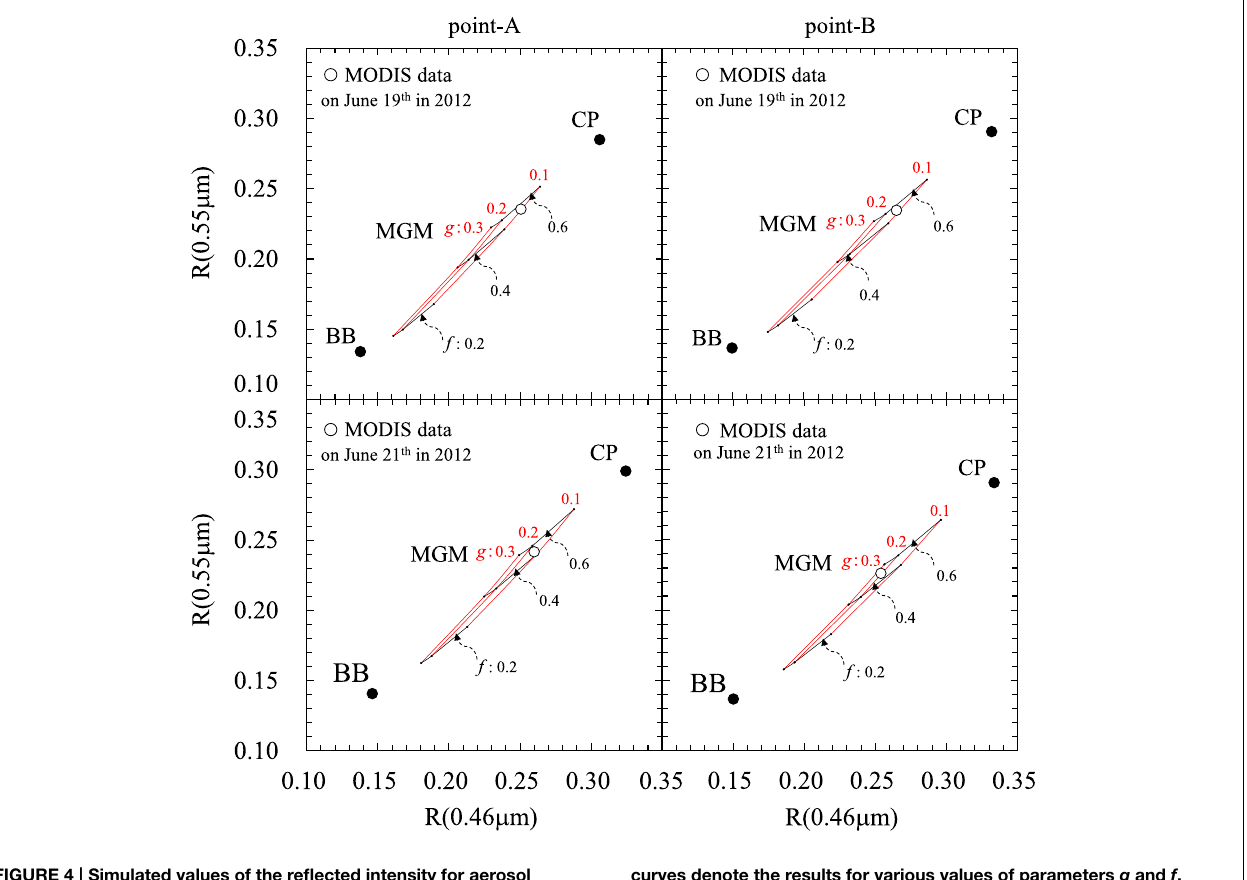
curves denote the results for various values of parameters g and f , respectively. The open circles denote MODIS data on June 19th and 21st in 2012 at the target points-A (left) and -B